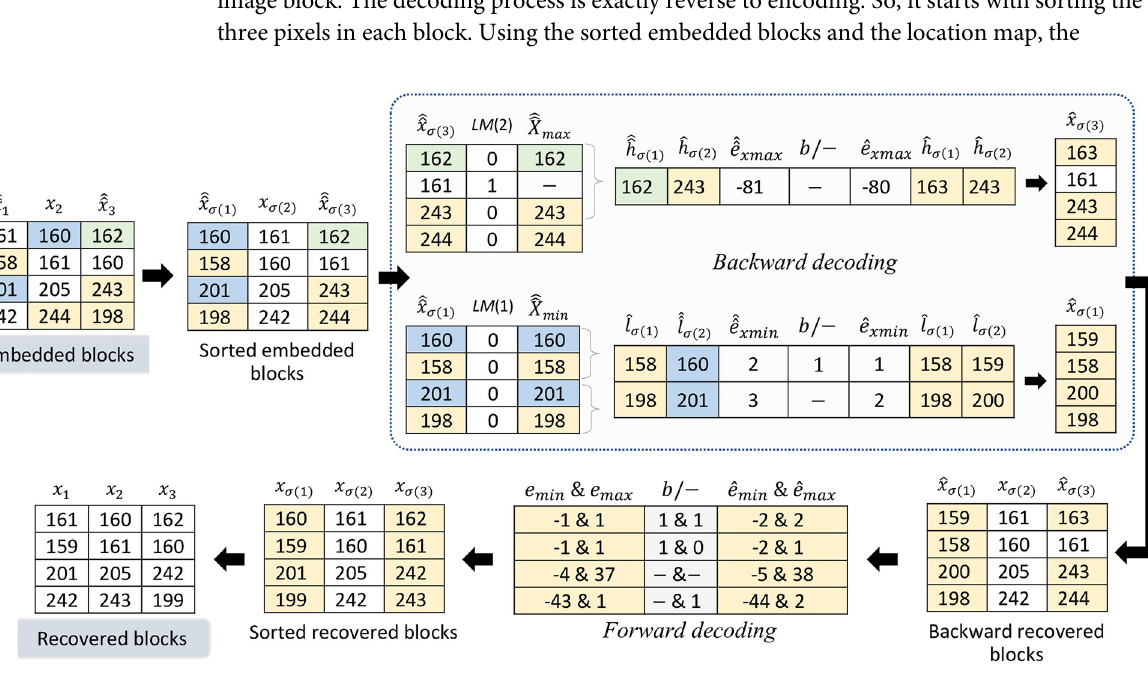
Fig 4. Example of the forward and backward decoding.